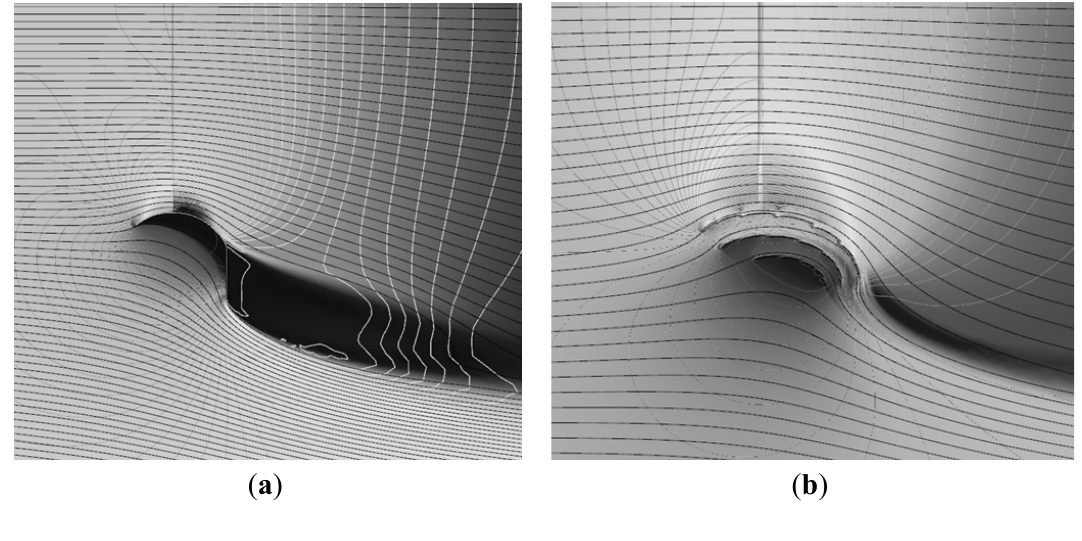
Figure 11. ( a ) Ohya Cii flanged DAWT; ( b ) New multi-element DAWT. Power-optimal loading configurations are